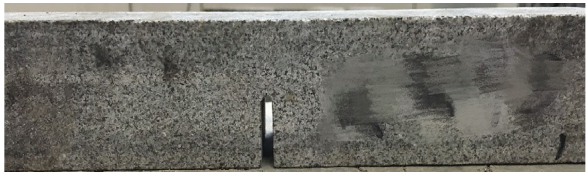
Figure 4: Tonalite specimen for three-point bending test.